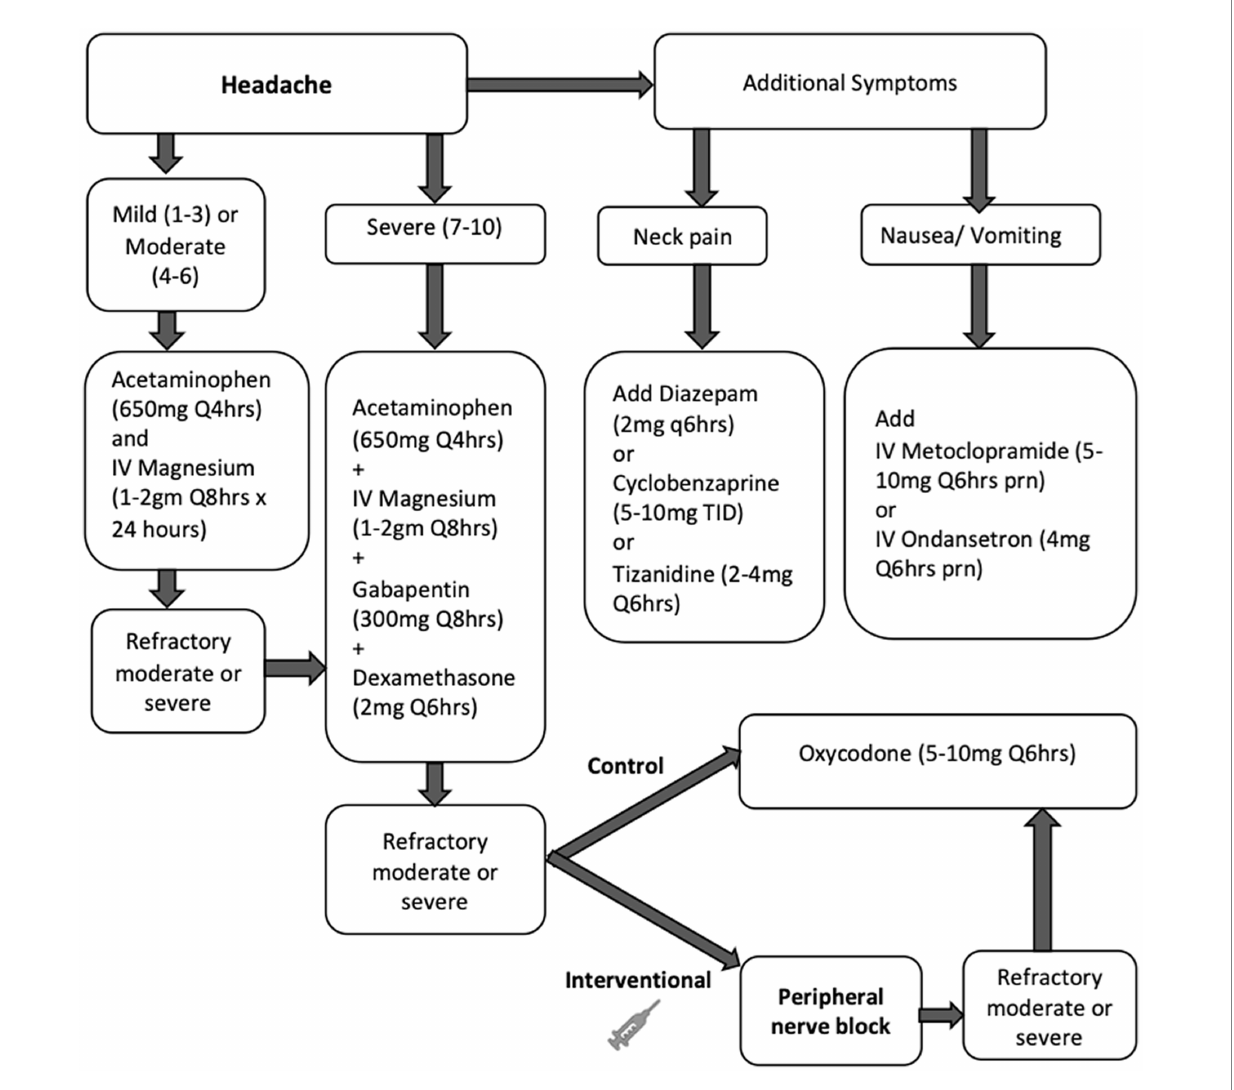
FIGURE 1 Study flow chart for treatment of HASH in the control (medications only) and intervention (peripheral nerve block) groups. Unless specified, medications were administered orally. Refractory headache was defined as a moderate or severe headache that persisted or worsened in intensity 1 h after